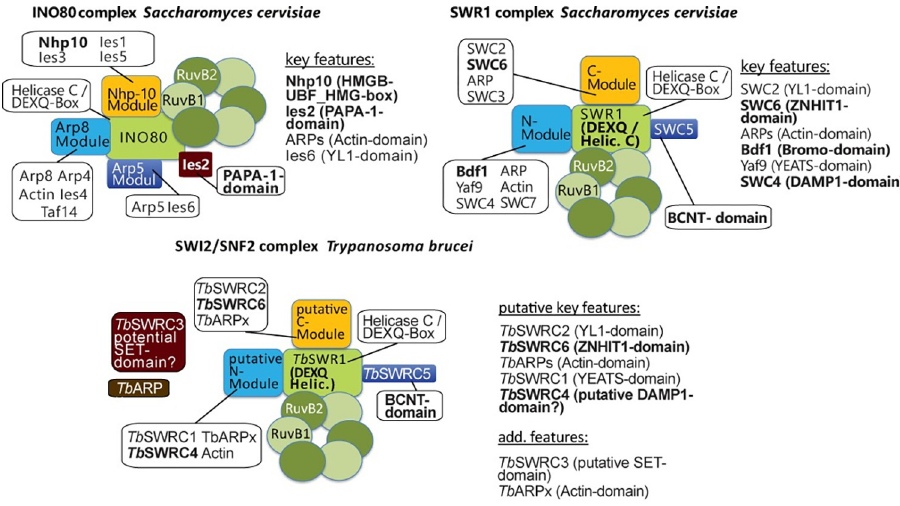
Fig 1. The Trypanosoma brucei SNF2 ATPase complex exhibits characteristics of a SWR1 complex. A comparison of the modular composition of the newly-identified SNF2 complex with the SWR1 and INO80 complexes of S . cerevisiae . INO80 complex S . cerevisiae : The Nhp-10 module forms a platform for nucleosome interaction. The Arp8 module is the nucleosome binding module, while the Arp5 module, which contains the YL1-domain protein Ies6 is responsible for the nucleosome remodelling step [14]. Ies2 with the PAPA-1-domain plays a structural role within the complex [14, 112]. INO80 specific domains are highlighted in bolt . SWR1 complex S . cerevisiae : Proteins listed under key features are essential for H2AZ incorporation [68]. The C-module of the SWR1 complex, which contains the Bromo-, YEATS- and SANT/DAMP1-domain mediates nucleosome affinity, while the N-module with the YL1- and Zinc finger ZNHIT1-domain is involved in the histone variant exchange reaction [49, 68]. SWR1 specific domains are highlighted in bolt letters [51, 68]. SWI2/SNF2 complex T . brucei : The identification of a BCNT- as well as a ZNHIT1 domain (highlighted in bold letters) hint toward the complex being a SWR1-like complex [51, 68]. Structure of the SWI2/SNF2 complex and its modules is only putative. The potential interaction interface of the species-specific proteins Tb SWRC3 and Tb ARPx is